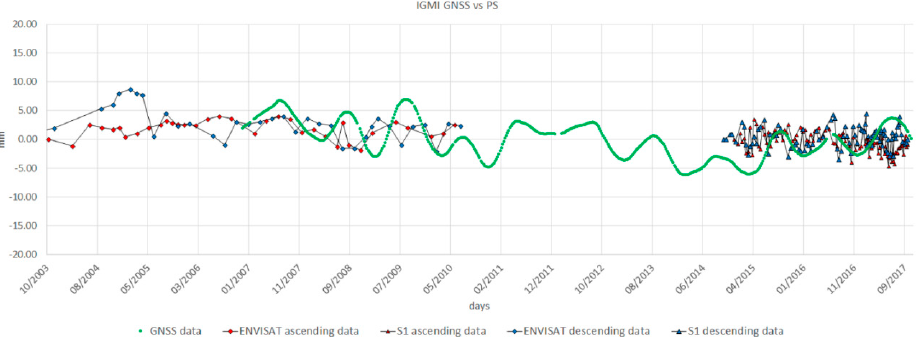
Figure 5. Comparison of the GNSS data recorded by the IGMI station and the nearby ENVISAT and Sentinel-1 PS data.